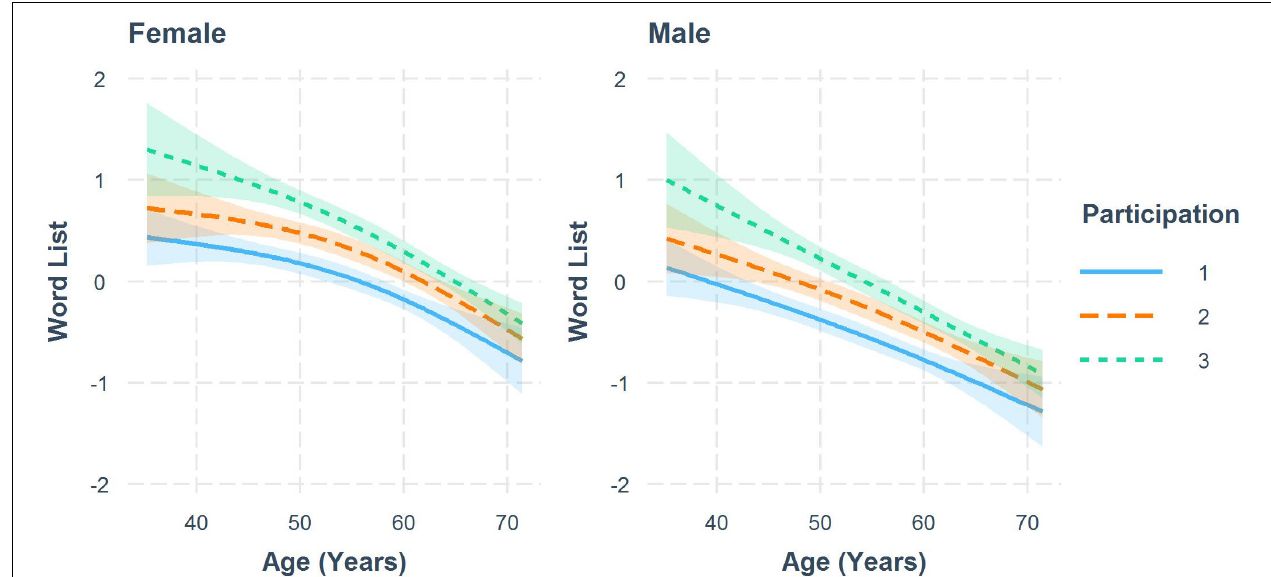
FIGURE 2 | Trajectories for standardized test results of the word list by number of study participations to visualize the practice effect for women and men with 95% CI. Results from a weighted linear mixed